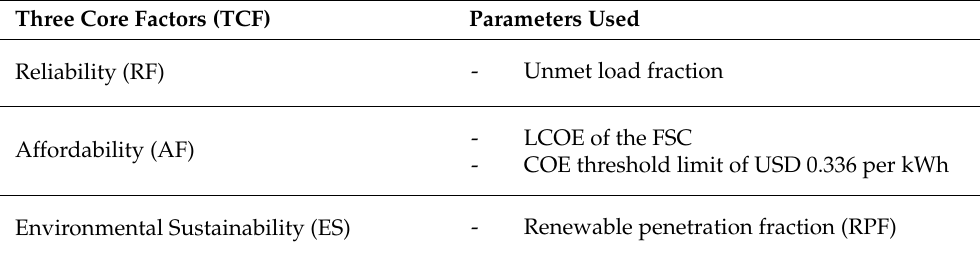
Table 5. Energy Trilemma (ET) index used in the ET scoring.